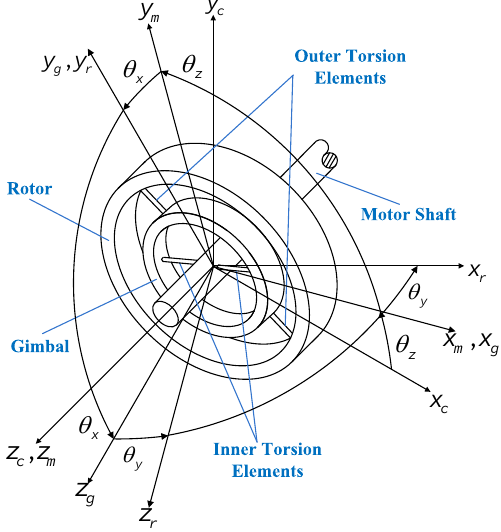
Figure 2. Coordinate frames with respect to the GyroWheel